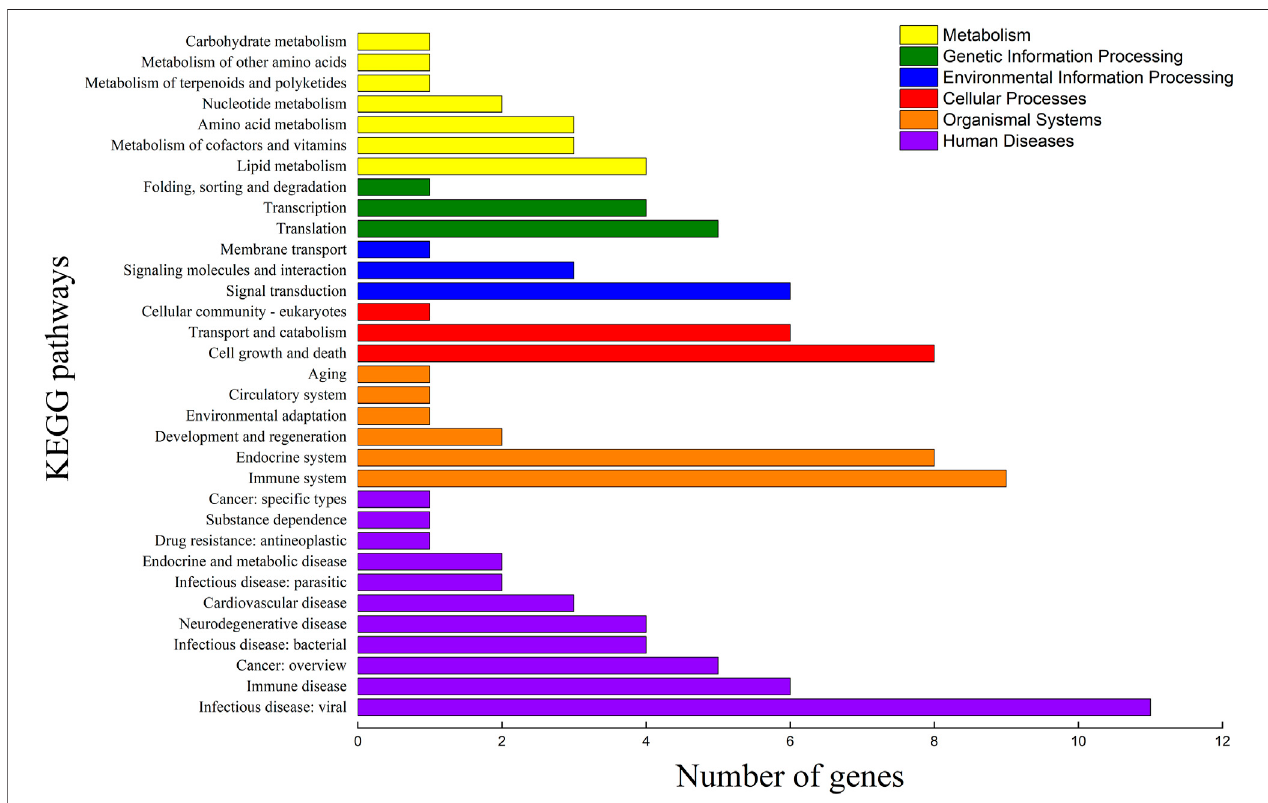
FIGURE 6 | KEGG pathway classi fi cation of DEGs. The x-axis indicates the number of DEGs (differentially expressed genes) matched in KEGG (Kyoto Encyclopedia of Genes and Genomes) pathway. The y-axis indicates the 33 KEGG subcategories.